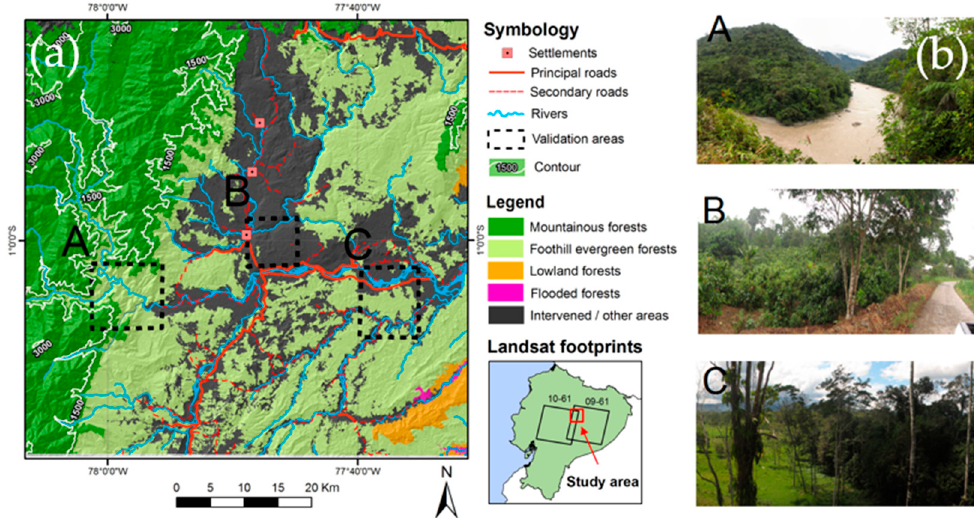
Figure 1. ( a ) Location of study areas. ( b ) Photographs observed at A, B, and C study areas. A is located in the vicinity of a protected area, B is located close to a settlement, and C is located in a private forest reserve, surrounded by agricultural land.